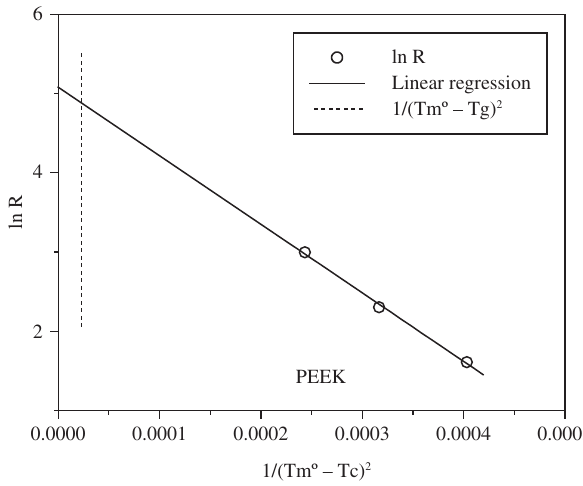
Figure 1. Fitting of the crystallization data to Equation 1 for obtaining the critical cooling rate for vitrification of PEEK. Vertical line represents the undercooling associated to Tg.